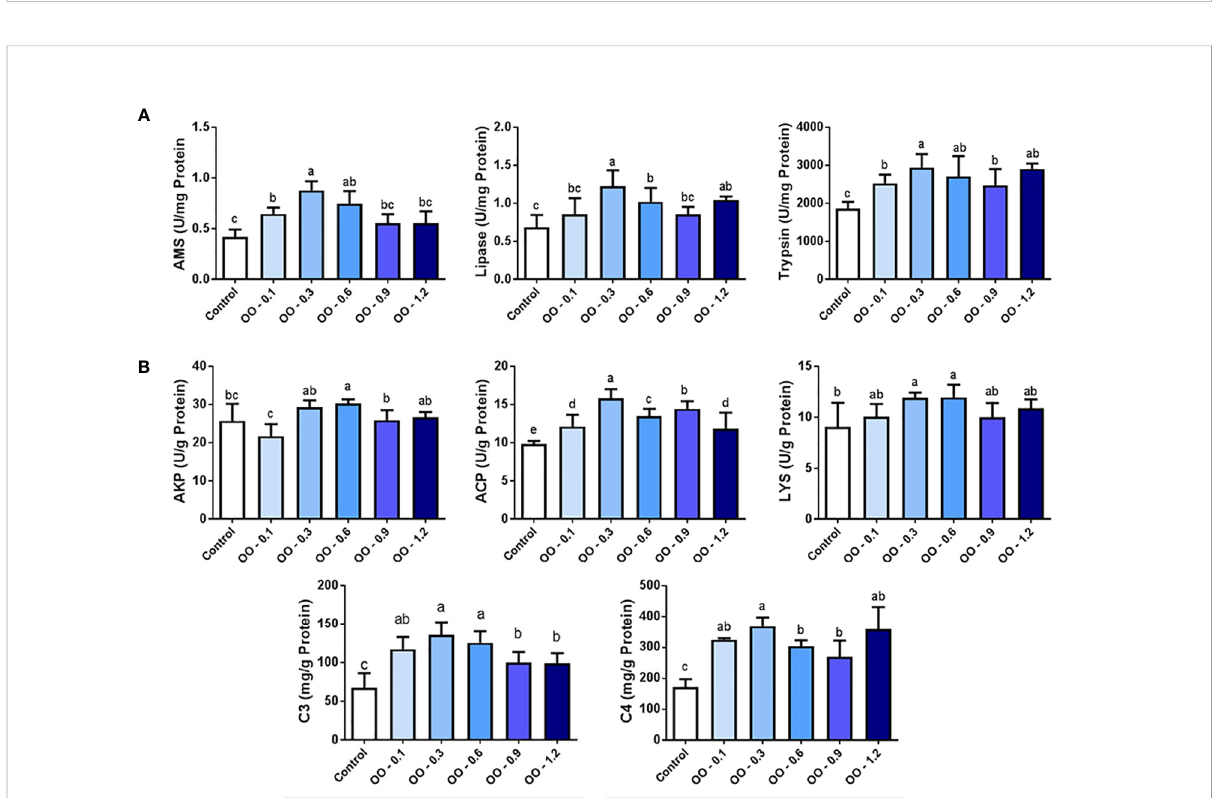
FIGURE 3 Effect of dietary oregano oil (OO) on the digestive enzyme activities and immunity capacity in the intestine of juvenile hybrid grouper fed the experimental diets for 8 weeks. (A) The content of amylase (AMS), lipase and trypsin. (B) The content of alkaline phosphatase (AKP), acid phosphatase (ACP),lysozyme (LYS), complement 3 (C3) and complement 4 (C4). Different lowercase letters show signi fi cant differences among treatments by Tukey ’ s test (P < 0.05).